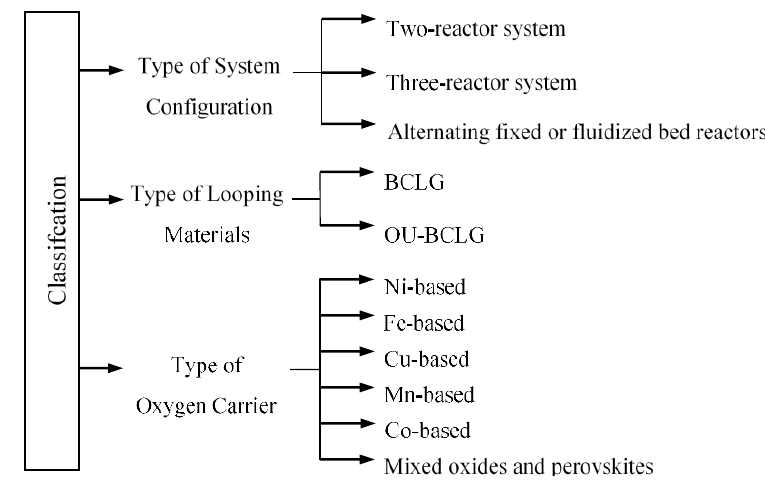
Figure 3. Classification of biomass chemical looping gasification process .